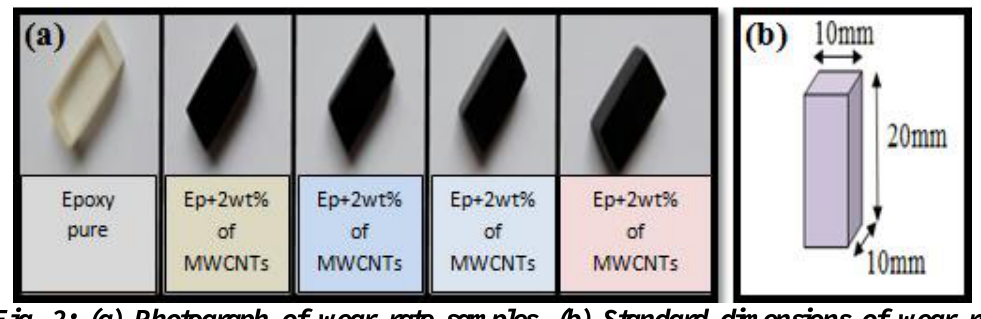
Fig. 2: (a) Photograph of wear rate samples. (b) Standard dimensions of wear rate sample.